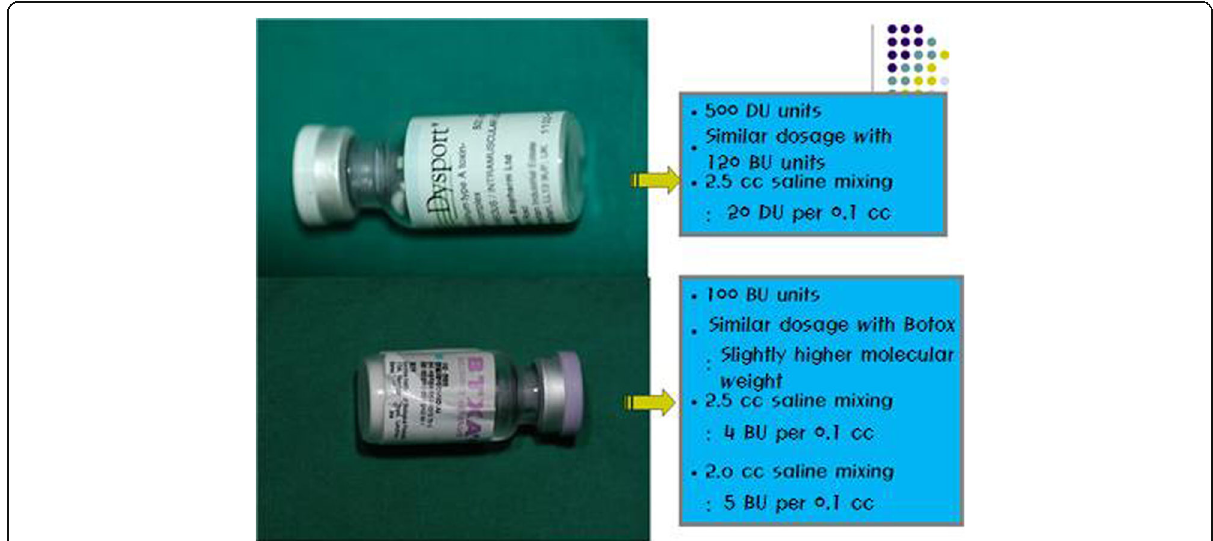
Fig. 7 Brand names for botulinum toxin A include Dysport, BTX-A, Botox, etc. The drugs differ from each other in their unit and possess different methods of injection depending on their method of dilution. For the treatment of bruxism, in the case of